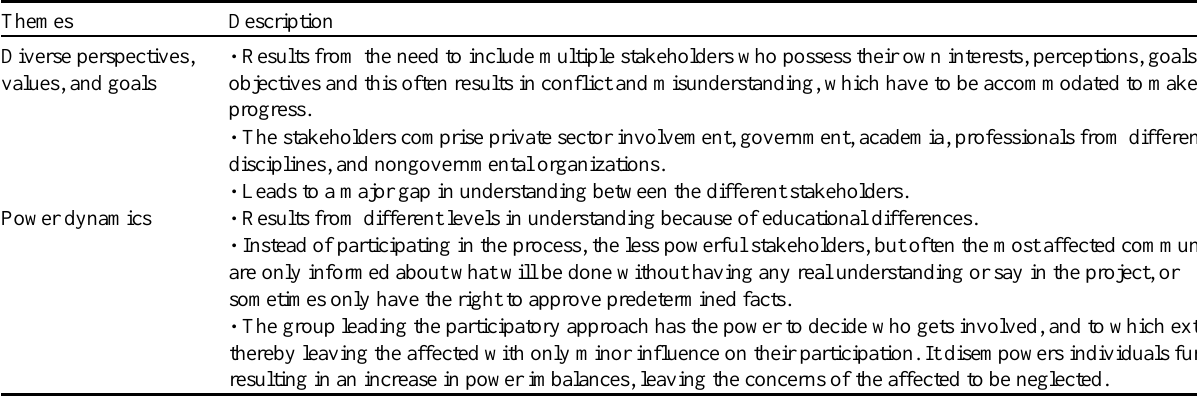
Table 1 . Commonalities in the three focus